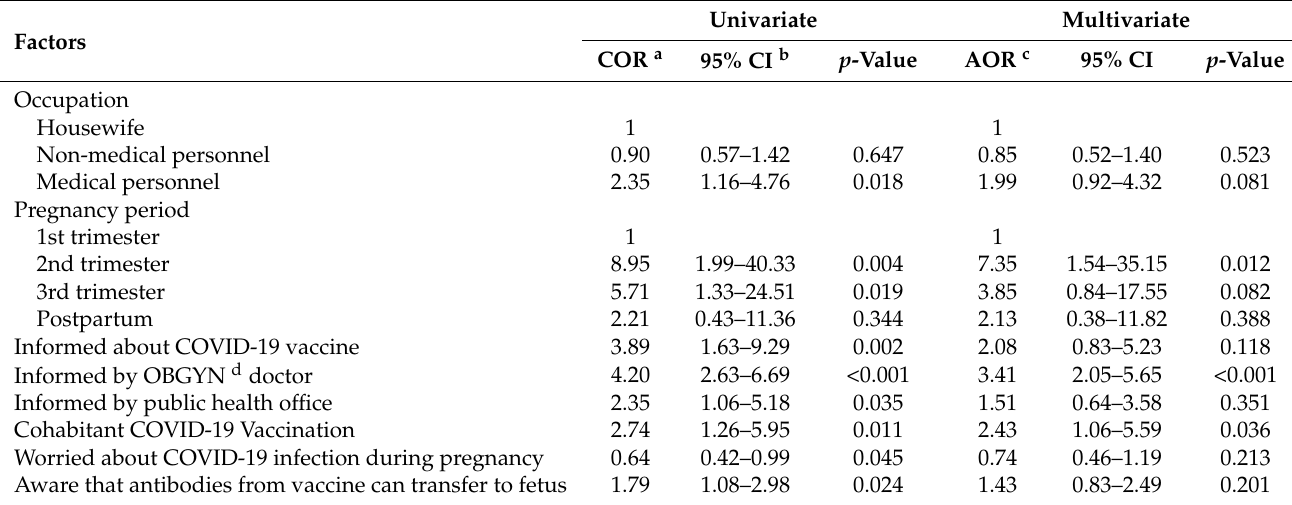
Table 3. Associated factors for maternal COVID-19 vaccination